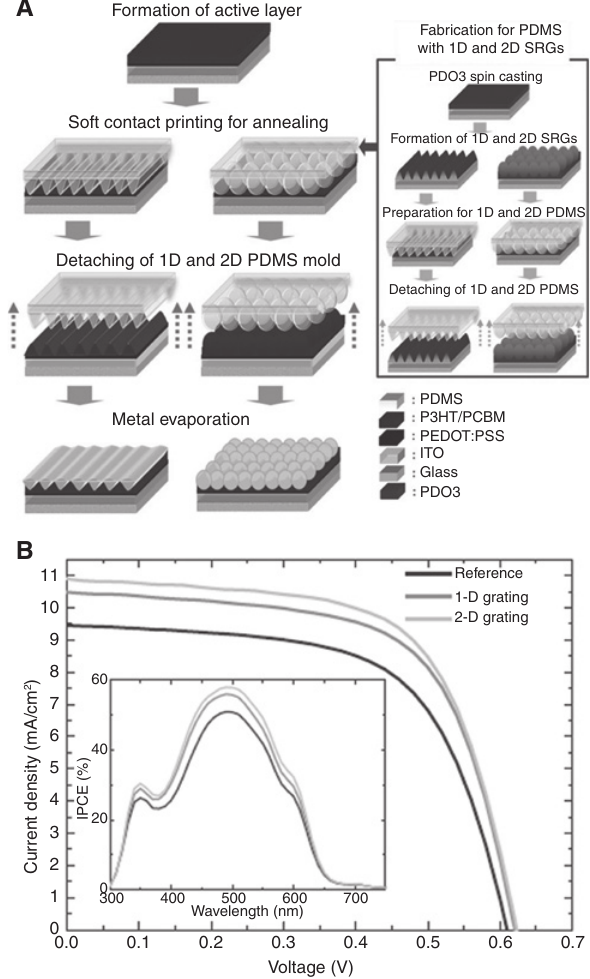
Figure 15: Use of 1D and 2D SRGs as templates for the fabrication of an organic solar cell with enhanced photon-current efficiency. (A) Schematic representation of the solar cell fabrication sequence. The PDMS molds obtained from the SRGs inscribed onto the azo- polymer are used to texture the organic active layer of the devices. (B) Comparison of the J-V characteristics for a flat active layer (reference) and the cells with 1D grating and 2D gratings